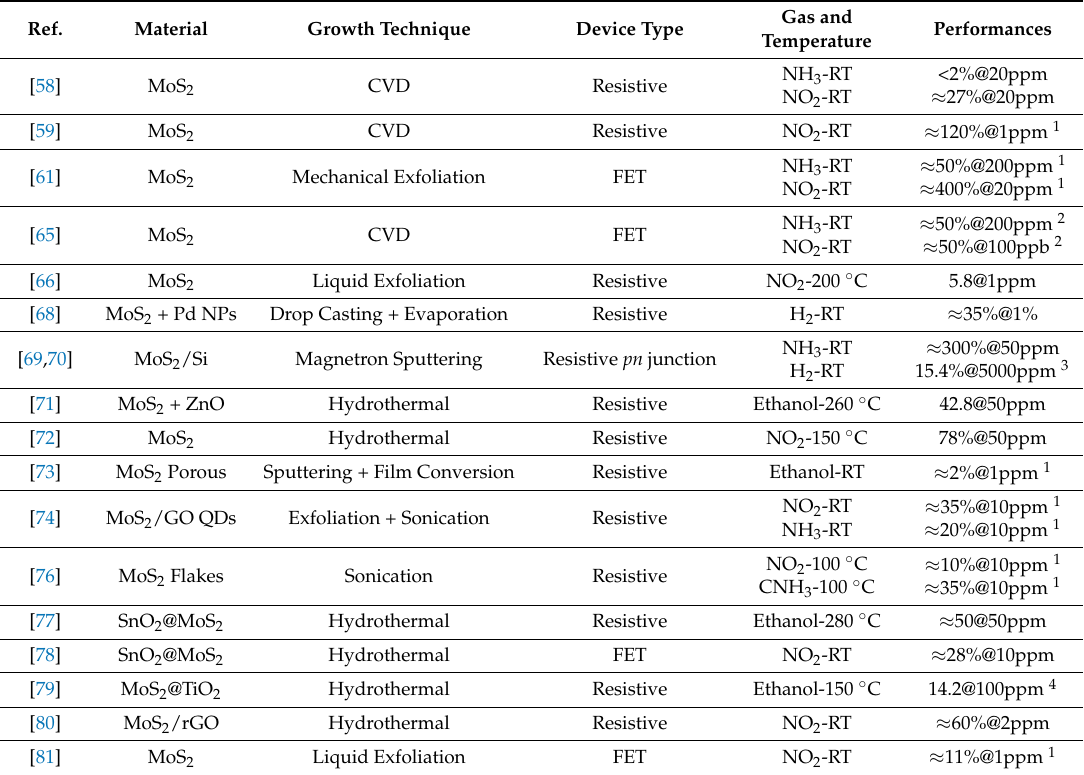
Table 2. Summary of MoS 2 gas sensing devices, target chemical compounds and performances. RT stands for room temperature ( 1 in N 2 atmosphere; 2 in Ar atmosphere; 3 in presence of a relative humidity (RH) of 30%; 4 in presence of a relative humidity (RH) of 45%).